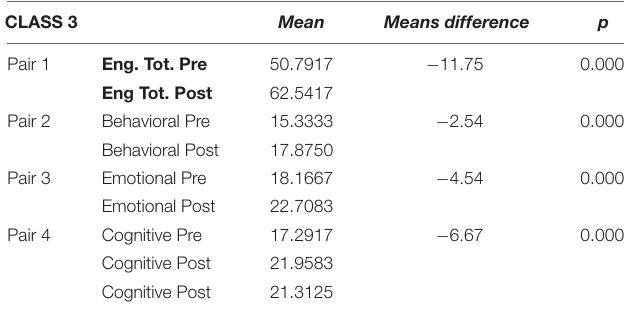
TABLE 12 | Emotions (PANAS) perceived by students, pre- and post.